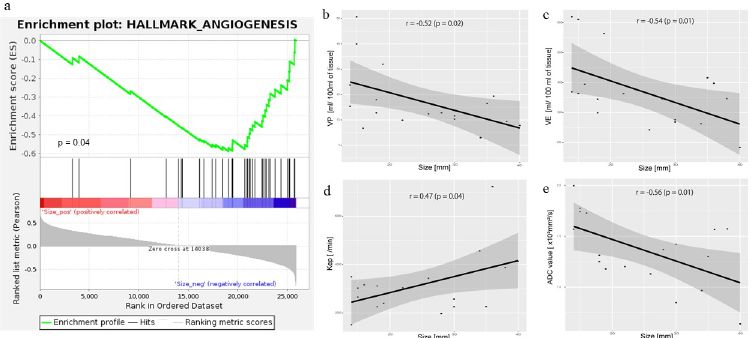
Fig 3. The relationships among tumor size, imaging parameters, and RNA expression. a: The GSEA revealed that decreased angiogenesis expression was significantly associated with increased tumor size (p = 0.041). b: The VP was inversely correlated with tumor size (r = − 0.52, p = 0.02). c: The VE was inversely correlated with tumor size (r = − 0.60, p = 0.01). d: The Kep was significantly correlated with tumor size (r = 0.47, p = 0.04). e: The ADC was inversely correlated with tumor size (r = − 0.57, p = 0.01).